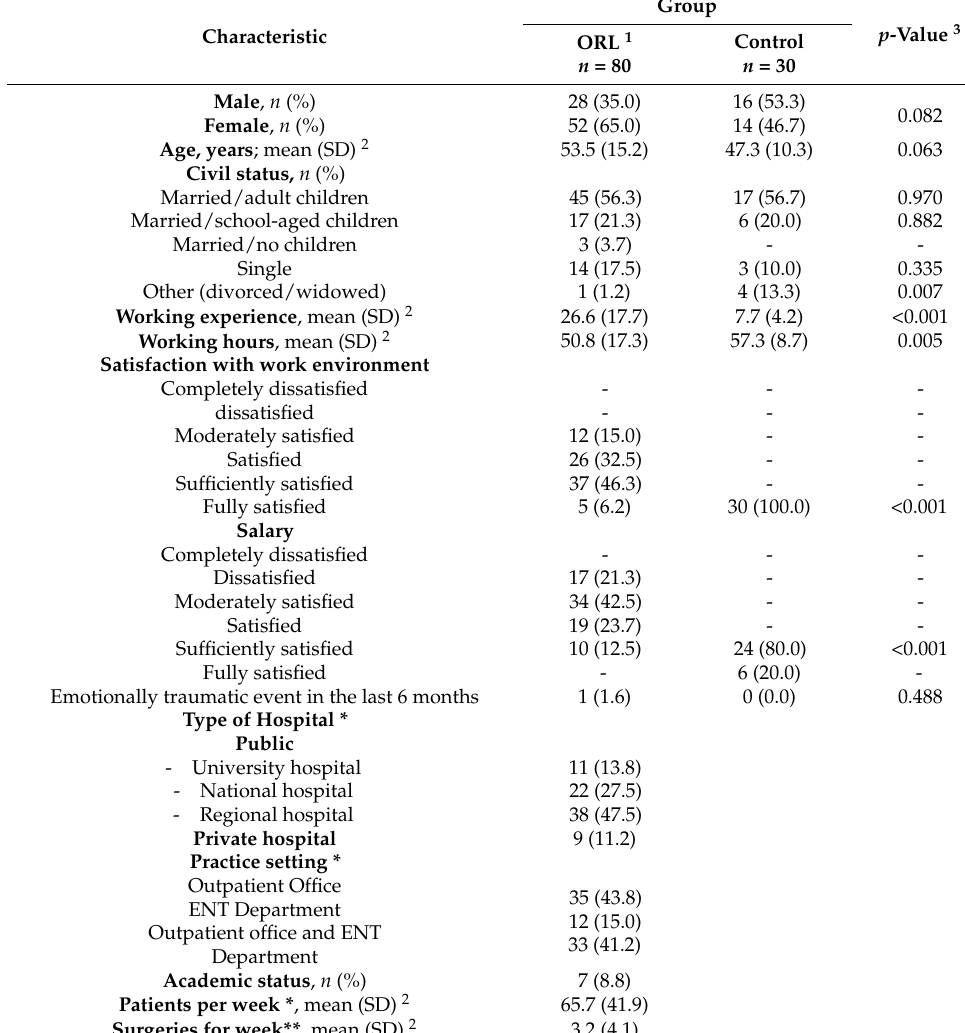
Table 2. Sociodemographic characteristics of the ORL and control